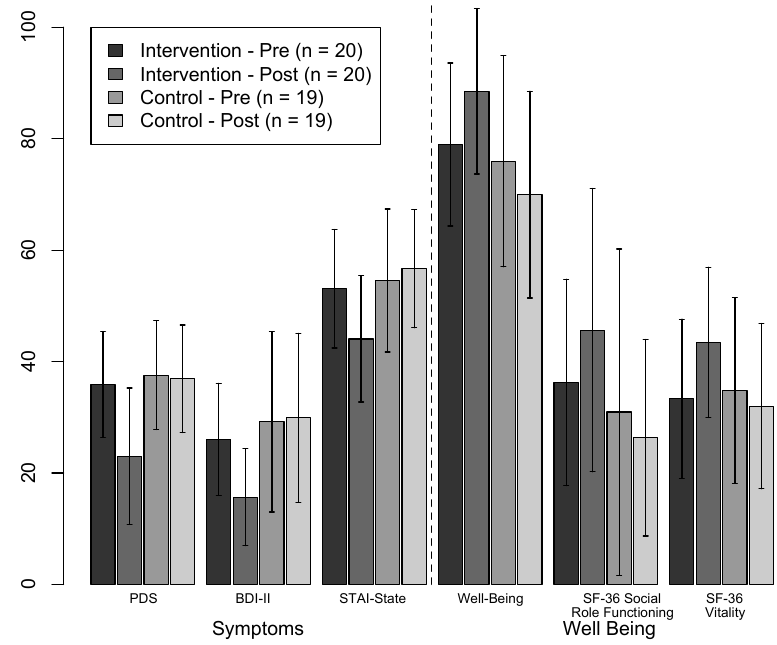
Figure 3. Mean scores on symptoms and well-being for treatment and wait-list control, pre- and post- intervention.